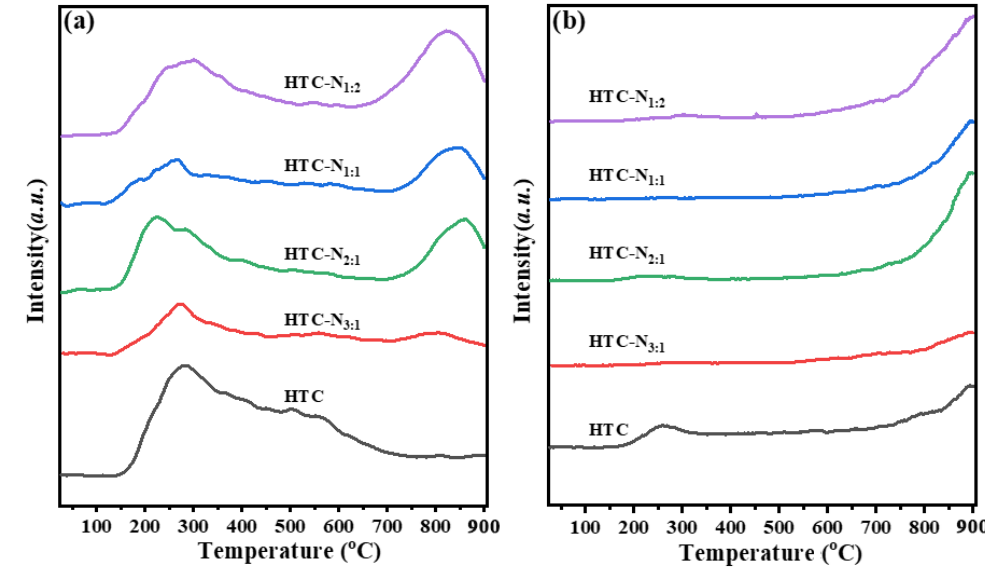
Figure 3. CO 2 -TPD ( a ) and CO-TPD ( b ) profiles of the resultant carbon supports.